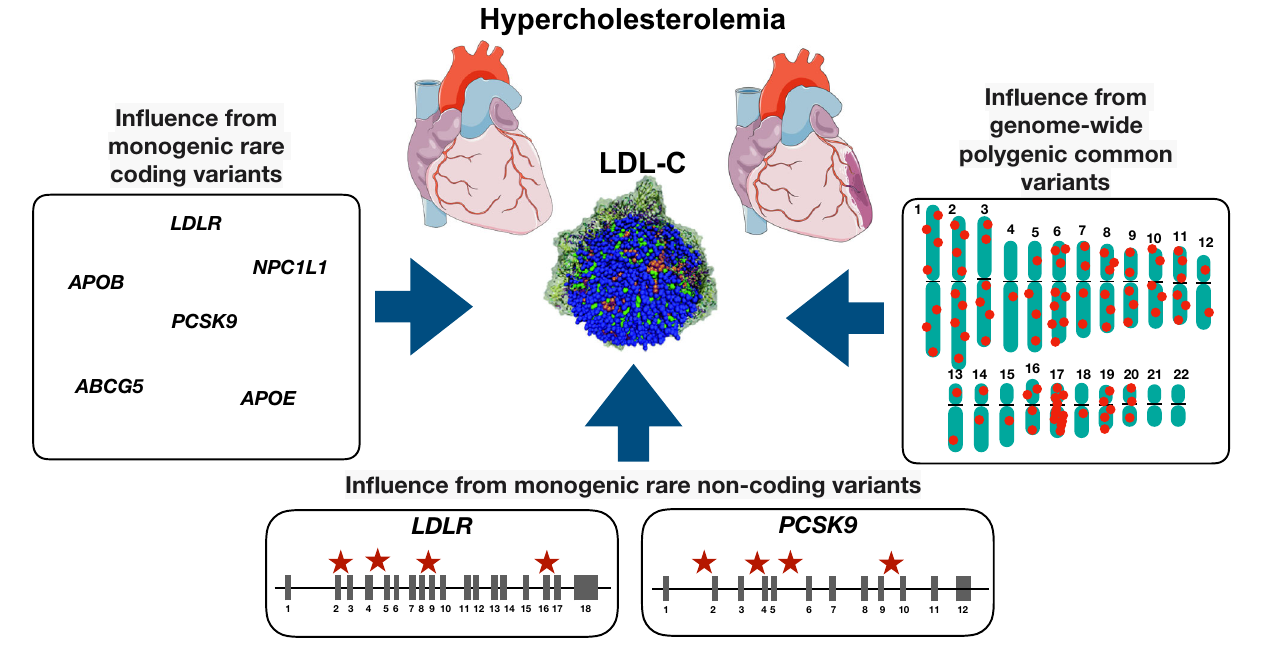
Fig. 5 | In fl uence of common and rare variants with hypercholesterolemia. In addition to monogenic contributions from rare variants in Mendelian hypercho- lesterolemia genes, multiple genome-wide signi fi cant LDL-C-associated common variants also yield apolygenic basisforhypercholesterolemia.In the present work, we now identify rare non-coding variants in proximity of Mendelian